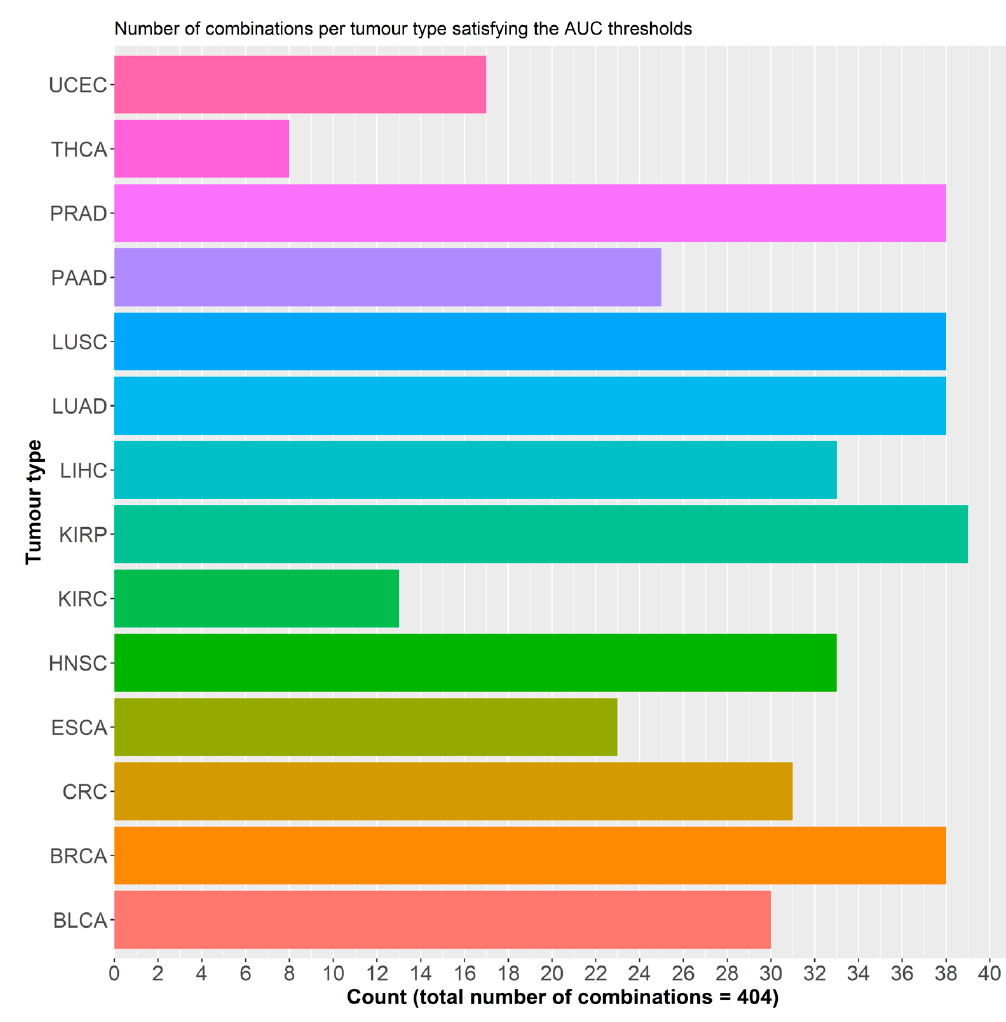
Figure 5. Countplot of the number probe combinations that satisfy the filters for each of the datasets. Please refer to Table 1 for tumor dataset abbreviations.